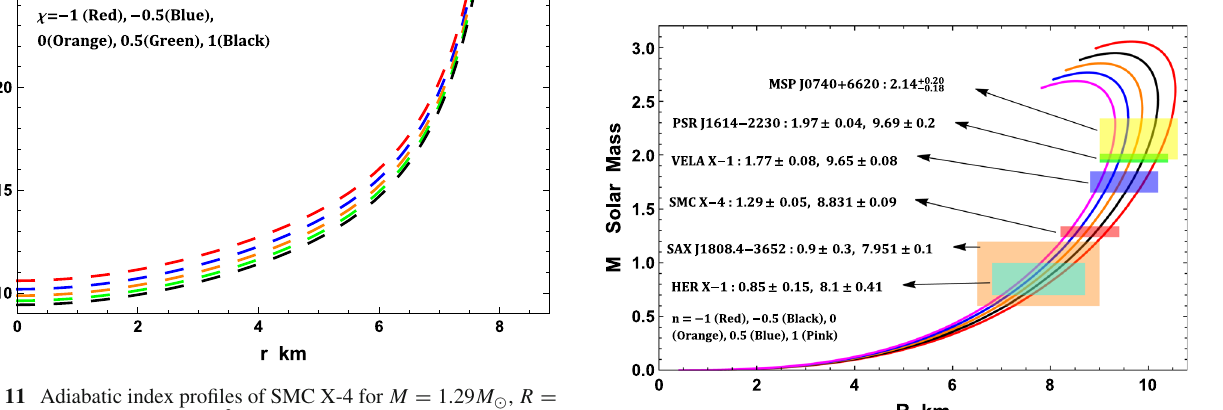
Fig. 13 M – ρ c curve and verification of static stability criterion